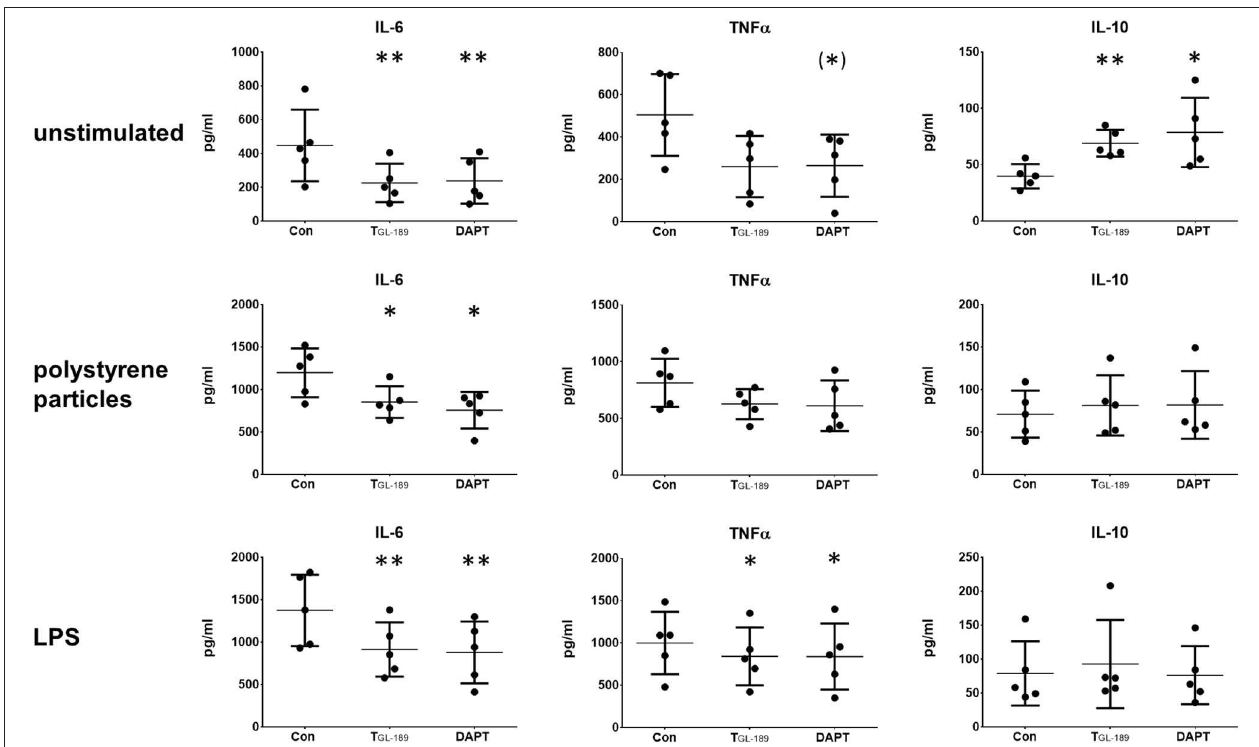
FIGURE 2 | Reduced secretion of IL-6 and TNF α after inhibition of APP processing. IL-6, TNF α , and IL-10 were determined by ELISA in cultures of primary human monocyte derived macrophages ( n = 5). Cultures were unstimulated (upper row), stimulated with 1 µ m polystyrene particles (seven particles/cell) (middle row) or stimulated with 10ng/ml LPS (bottom row). The secretion of A β peptides was inhibited with 500nM of the β -secretase inhibitor T GL − 189 or 10 µ M of the γ -secretase inhibitor DAPT. Results are presented as mean with standard deviation. ELISA were carried out in duplicates. Each point represents a biological replicate and is the mean value of the duplicates. The significance of the differences was evaluated with the ratio-paired t -test between cultures treated with secretase inhibitors and those without. (*) p < 0.1 (trend); * p < 0.05; ** p <